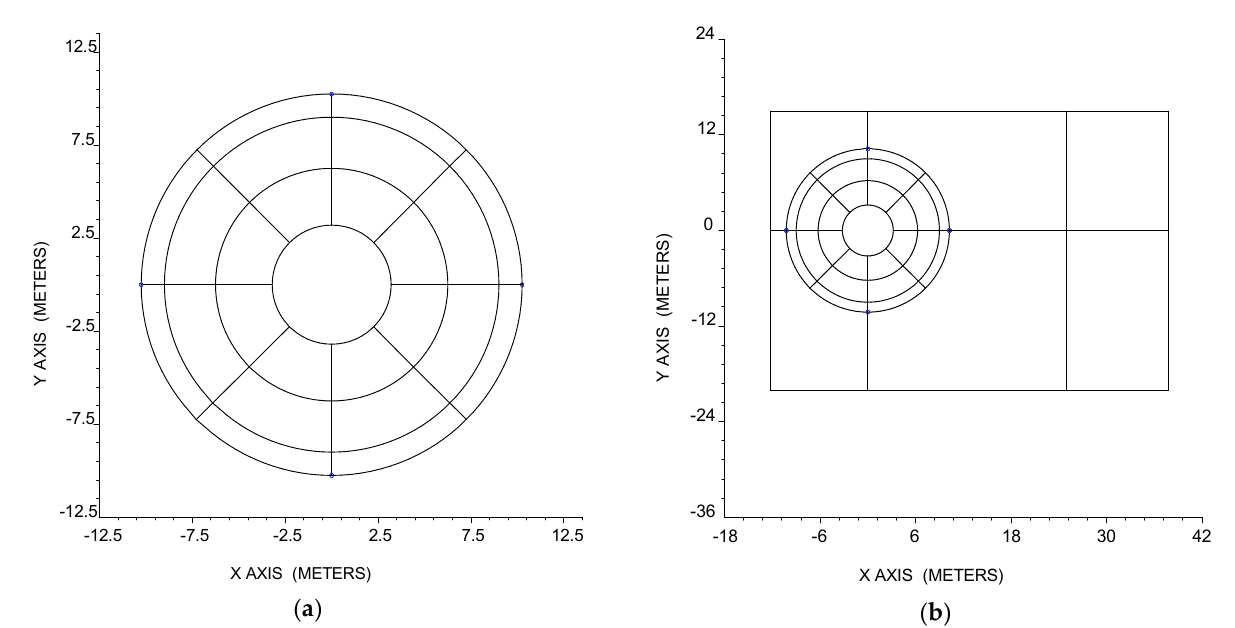
Figure 9. Top view of a typical wind turbine earthing system: ( a ) foundation earthing system, ( b ) enhanced earthing sys- tem.